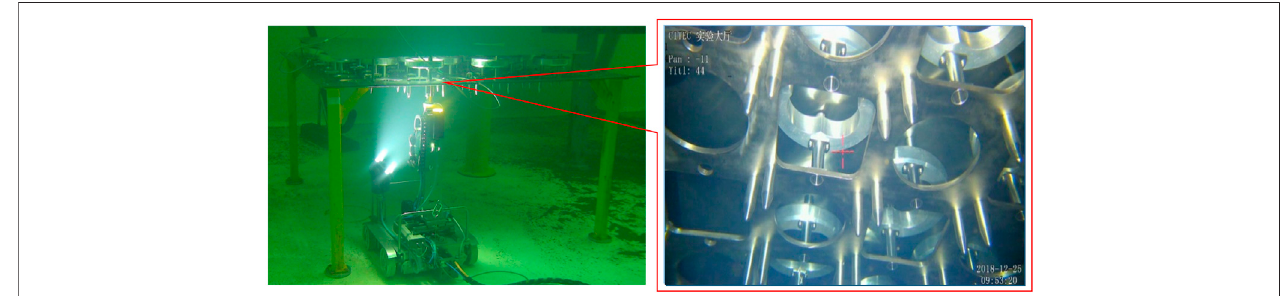
FIGURE 11 | Robot with transducer for underwater